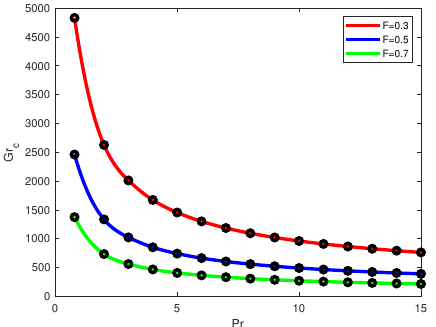
Figure 16. Critical Grashof numbers versus Pr for Case